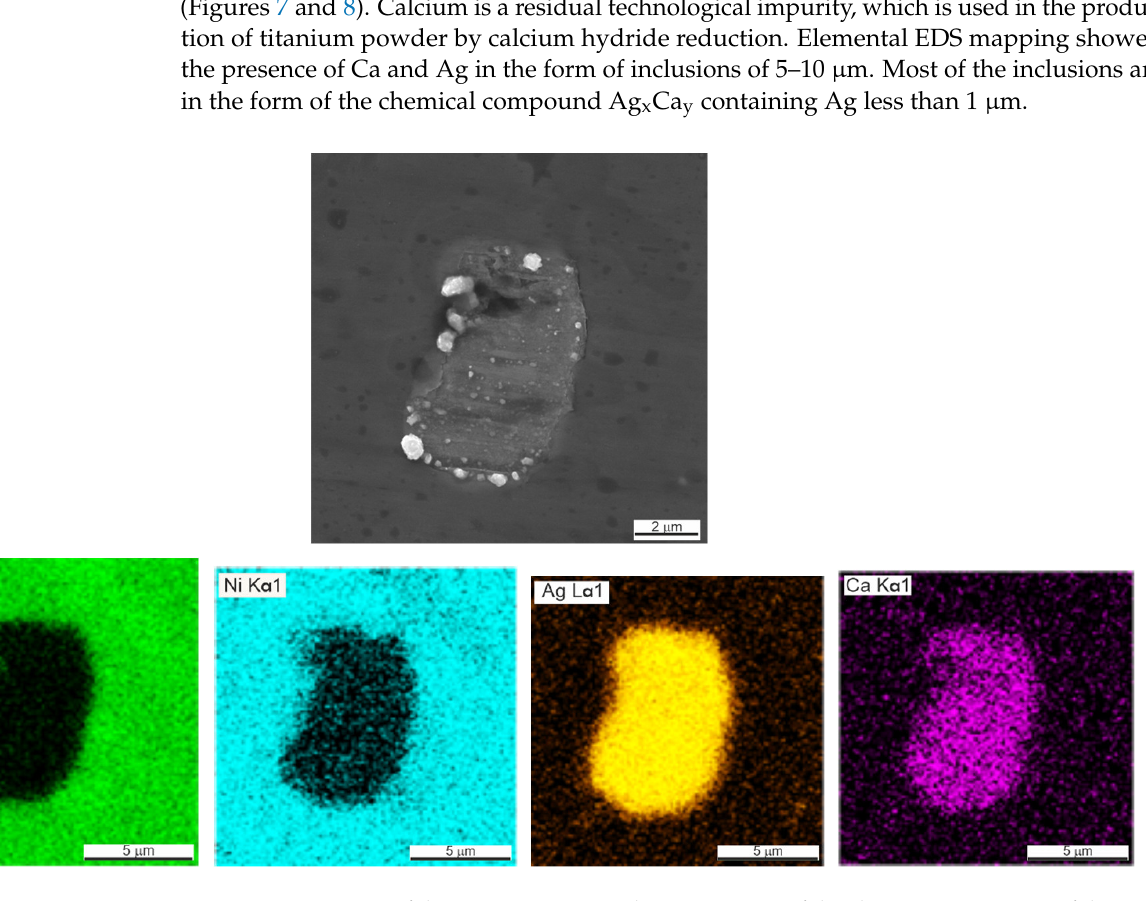
Figure 8. The dependence of the particle size containing silver on the Ag dopant concentration. Ag and Ca form a number of chemical compounds [25] which contain some of the detected Ag in a dissolved state. Some amount of the unreacted Ag was found in a free state or in the compound with the predominant content of silver, Ag 9 Ca 2 , Ag 7 Ca 2 The results of the EDS mapping of TiNiAg (0.2–0.5) samples showed that inclusions containing silver are located mainly in the zones of Ti 2 Ni peritectic crystallization. The temperature of Ti 2 Ni peritectic crystallization is about 950 °C, while the crystallization of all Ag–Ca system compounds occurs in the range of 750–910 °C. With an increase in the Ag concentration in the alloy from 0.2% to 0.5%, the size of agglomerates from inclusions containing Ag increases from 0.2 to 6 µm (Table 5 and Figure 8). Table 5. The size of agglomerates of inclusions with silver. Sample